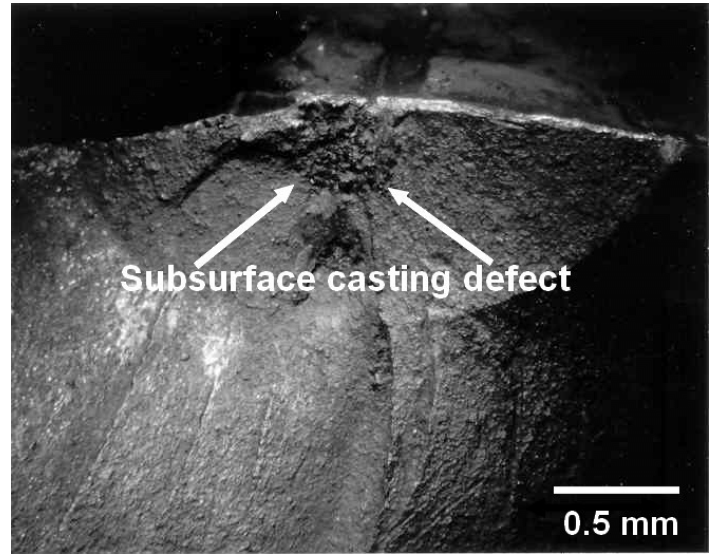
Figure 15. Typical subsurface defect at the inner pedestal leg of a side frame.